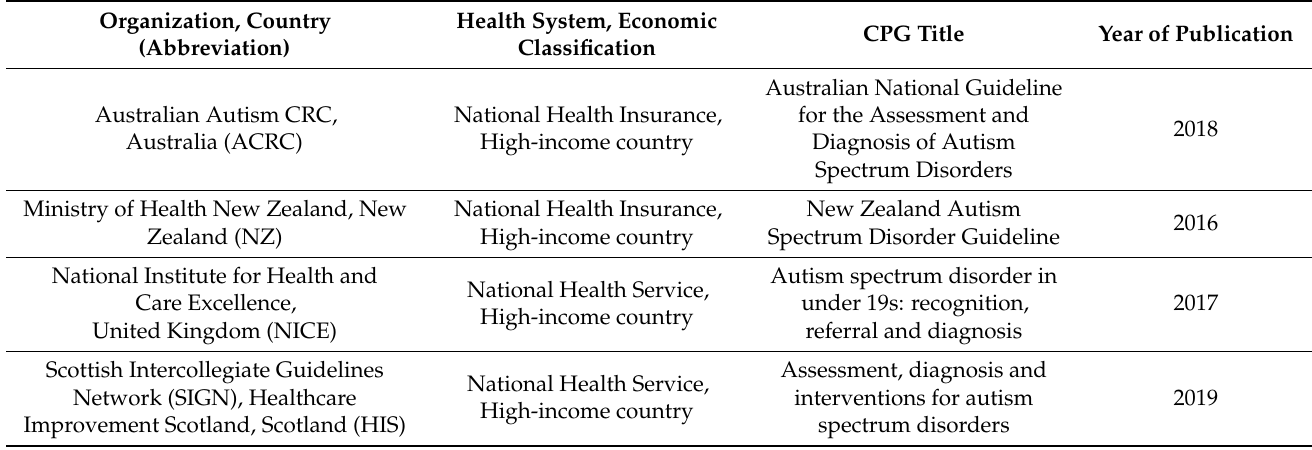
Table 1. Characteristics of included ASD CPGs.